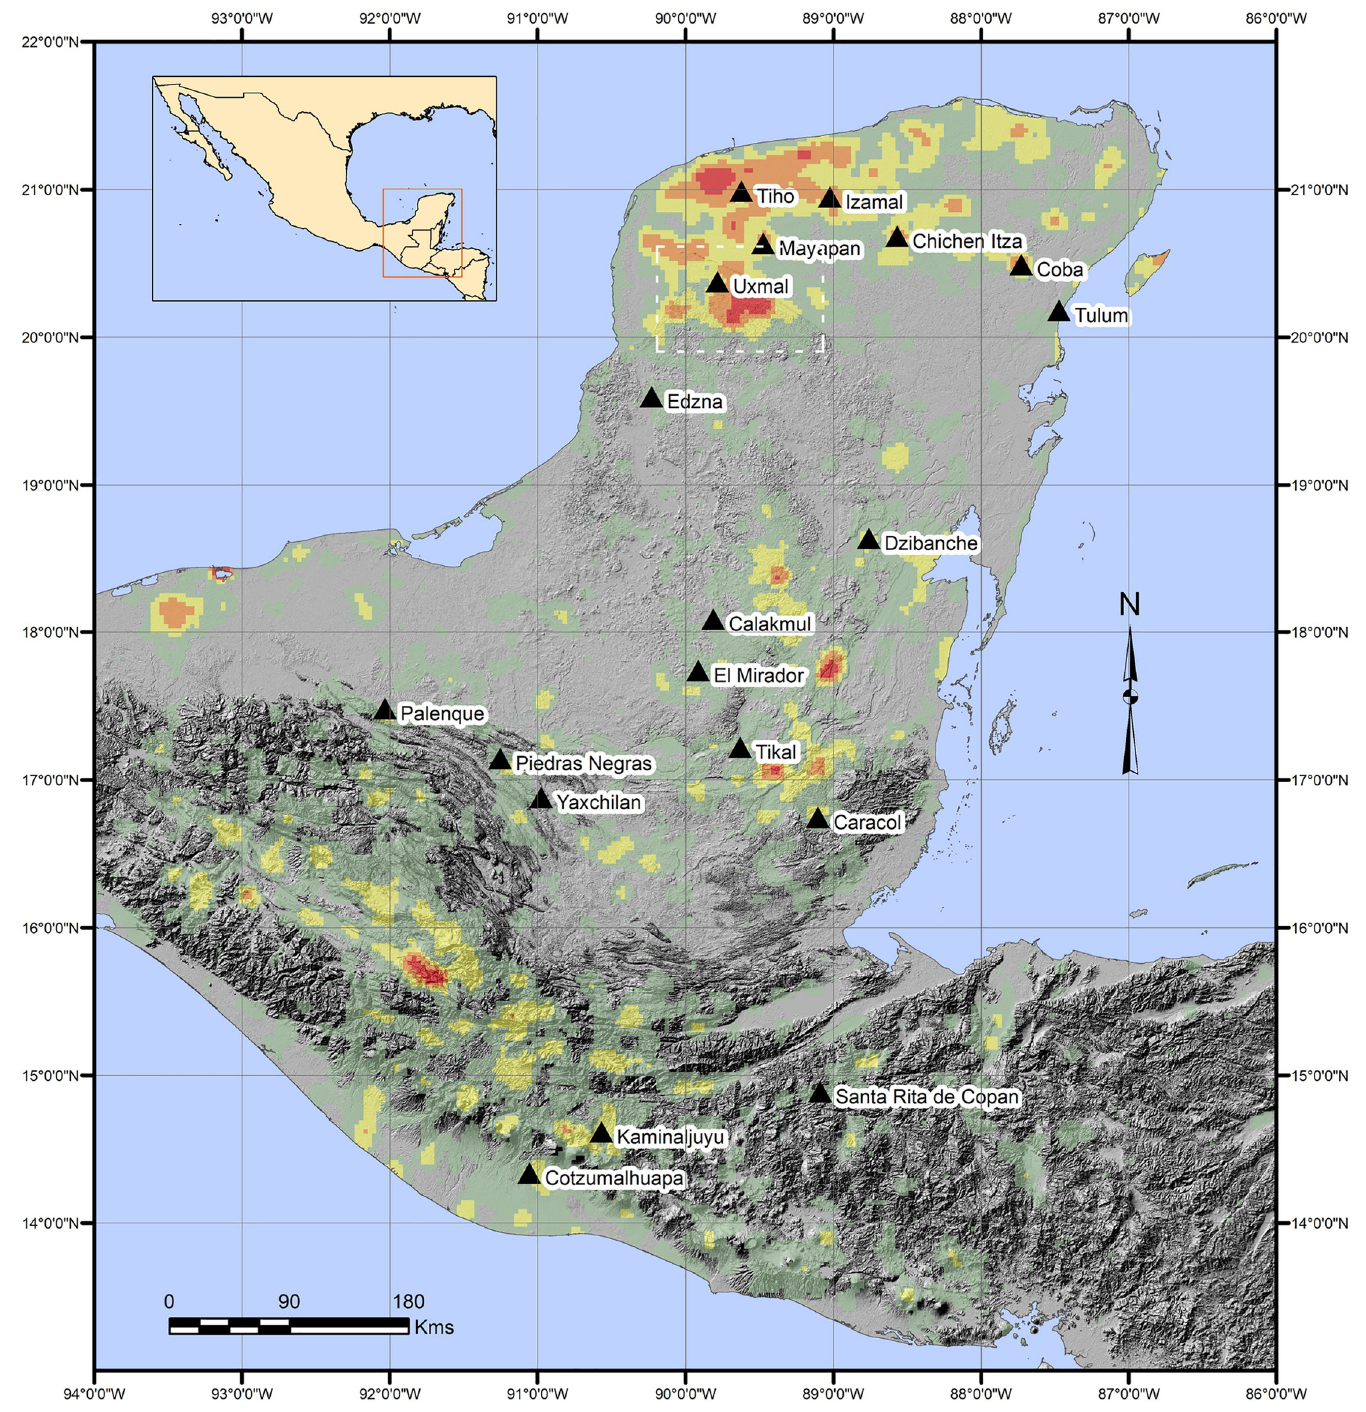
Fig 2. Site density in the Maya area. Red signifies zones of high density. Because survey coverage is uneven, and no attempt is made to account for site size or date of occupation, this should not be taken as a representation of actual population density. (Based upon the Electronic Atlas of Ancient Maya Sites [8]; data courtesy of Walter